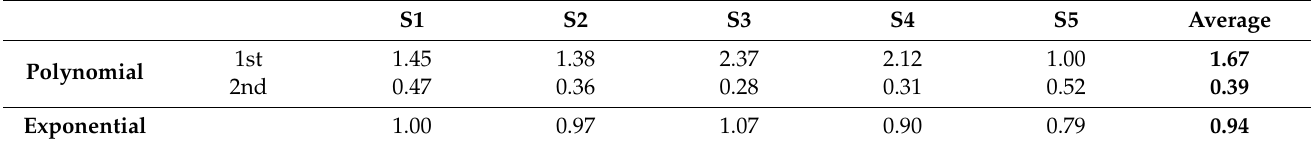
Table 2. Root mean square error (RMSE) of five chicken breast samples (units: ◦ C).